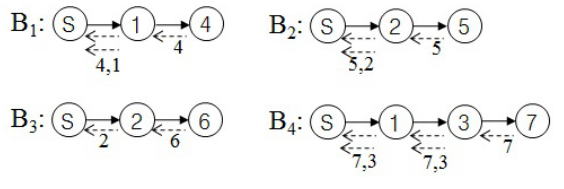
Figure 5. Query and response